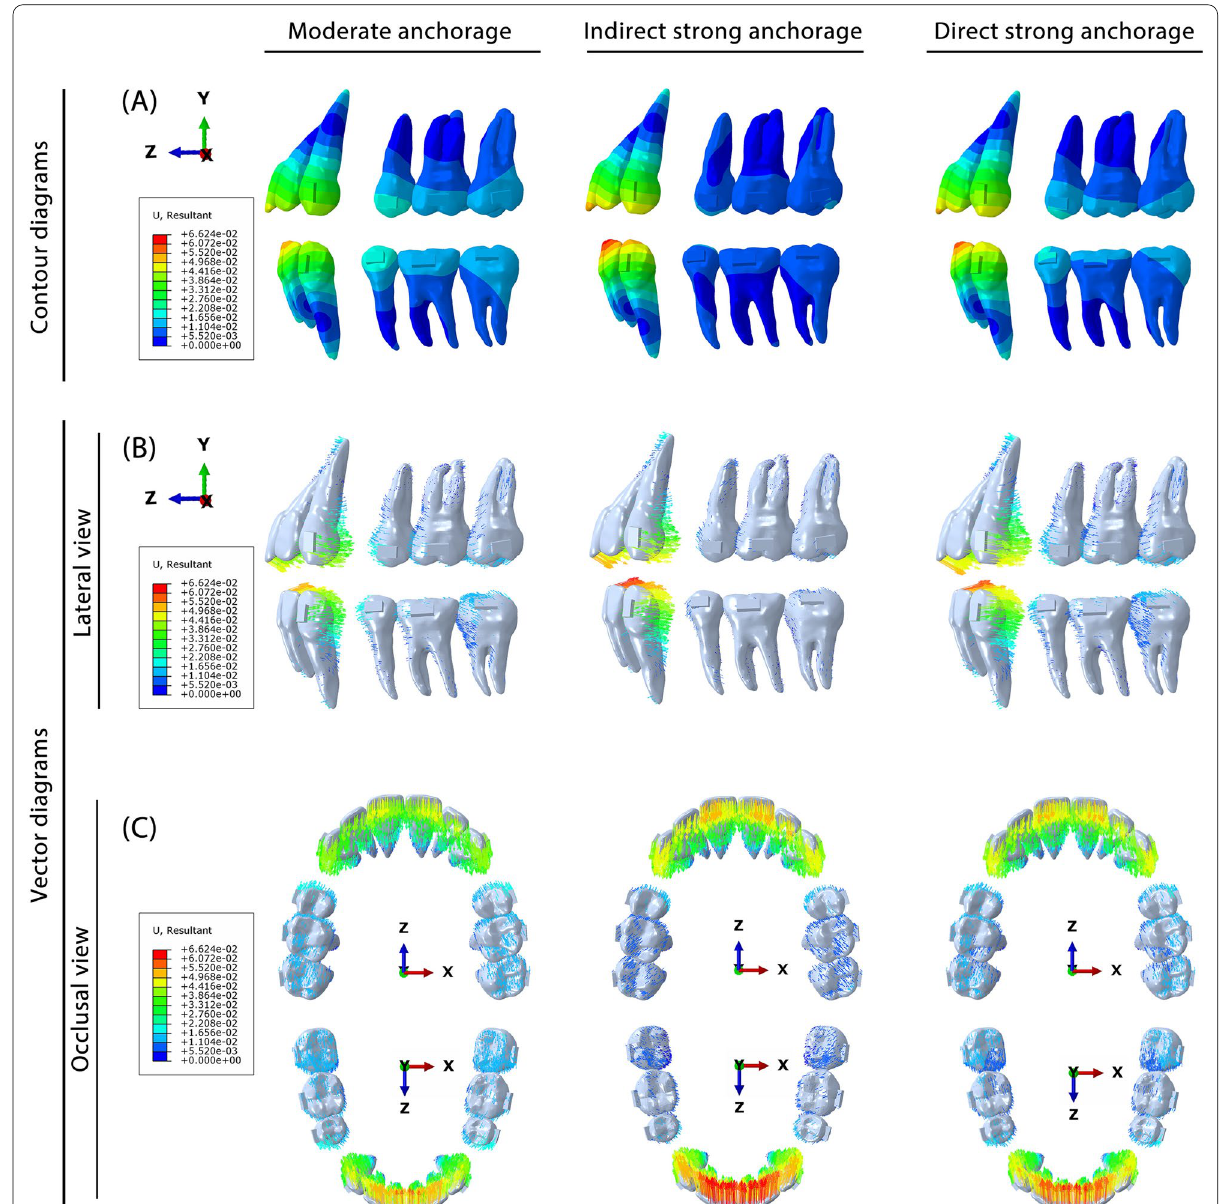
Fig. 3 Biomechanical effects of CAs on bimaxillary space closure under different anchorages. A ) Contour diagram reflecting the displacement tendencies of bimaxillary teeth. B , C Vector diagram reflecting the displacement directions and the amount of the bimaxillary